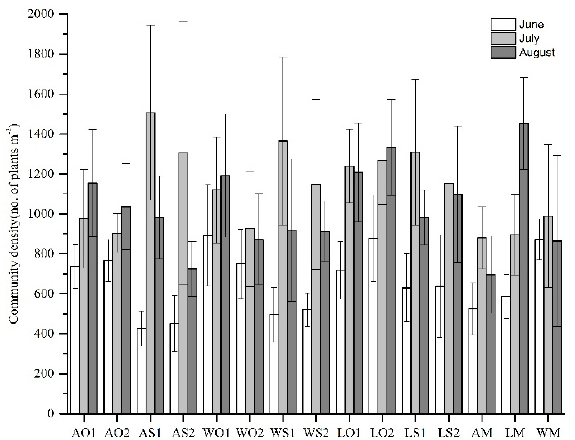
Figure A3. The community density among all treatments during the growing season (mean ± SD). The abbreviations are the same as above.